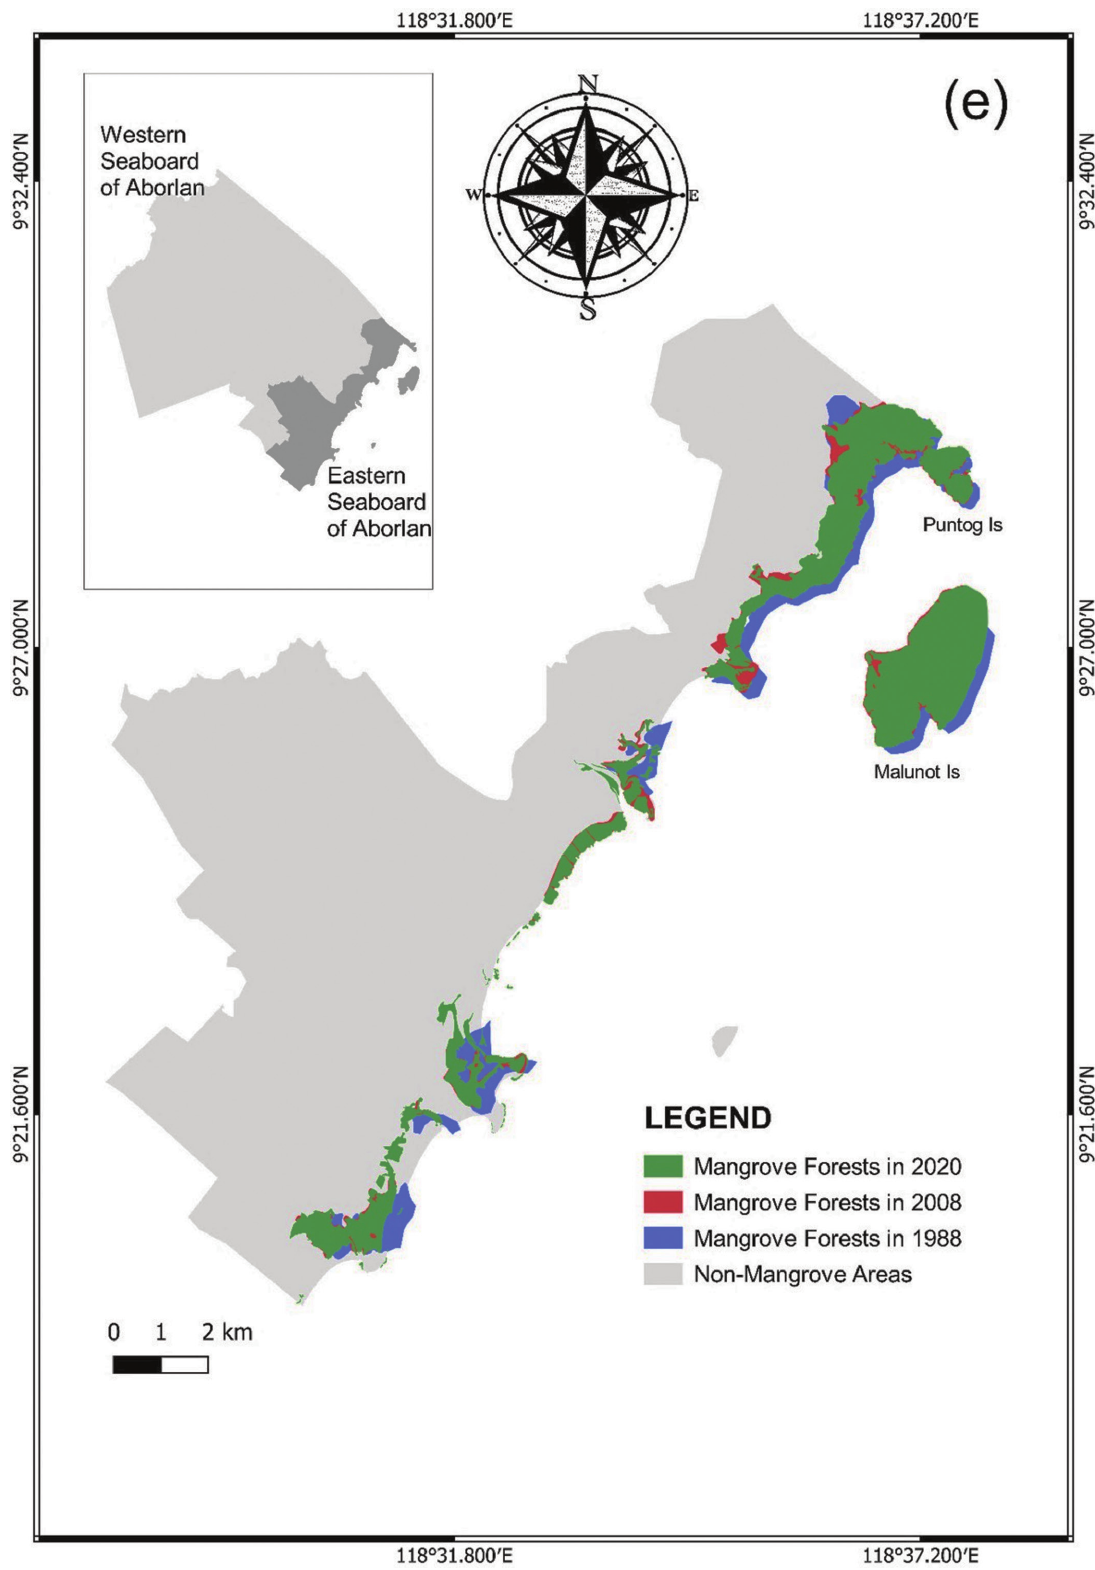
Multi-spatiotemporal analysis of changes in mangrove forests in Palawan, Philippines UCL OPEN ENVIRONMENT